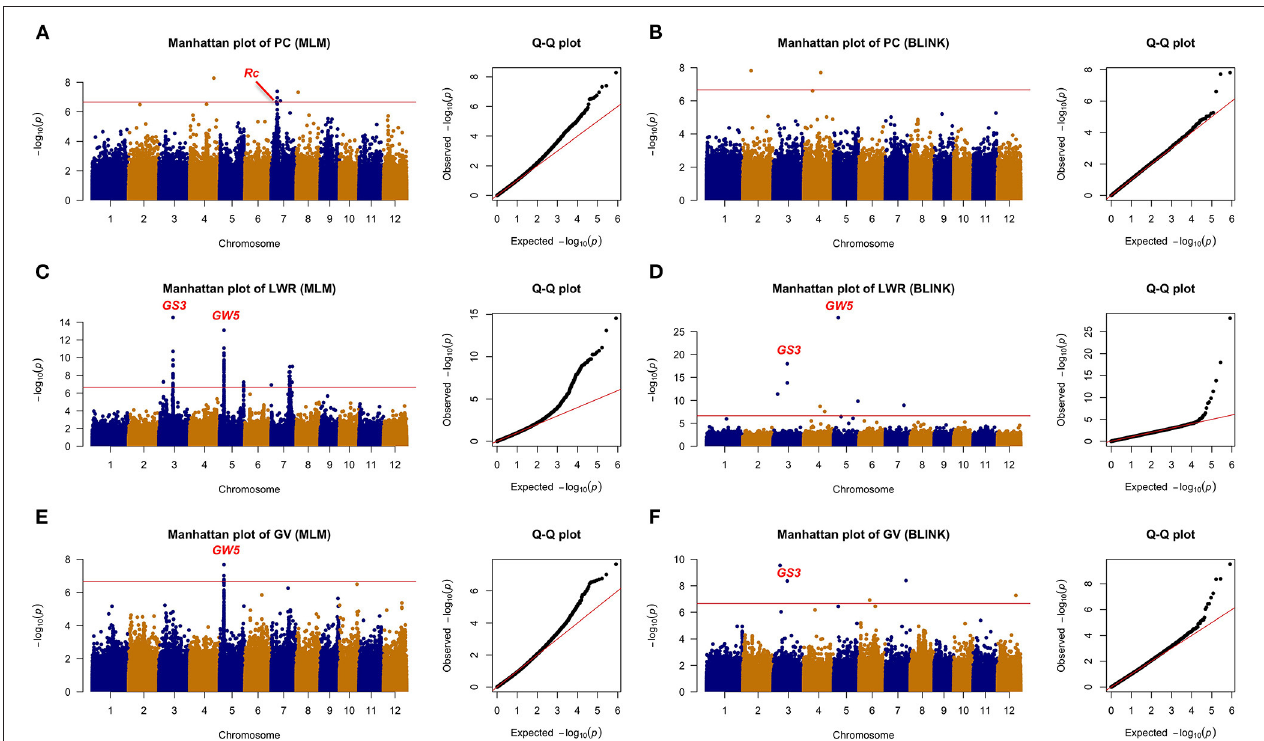
FIGURE 5 | The genome-wide association analysis of appearance with MLM and BLINK methods. (A) PC with MLM, (B) PC with BLINK, (C) LWR with MLM, (D) LWR with BLINK, (E) GV with MLM, and (F) GV with BLINK. The horizontal red line indicated the significance thresholds at –log10( p ) = 6.66.